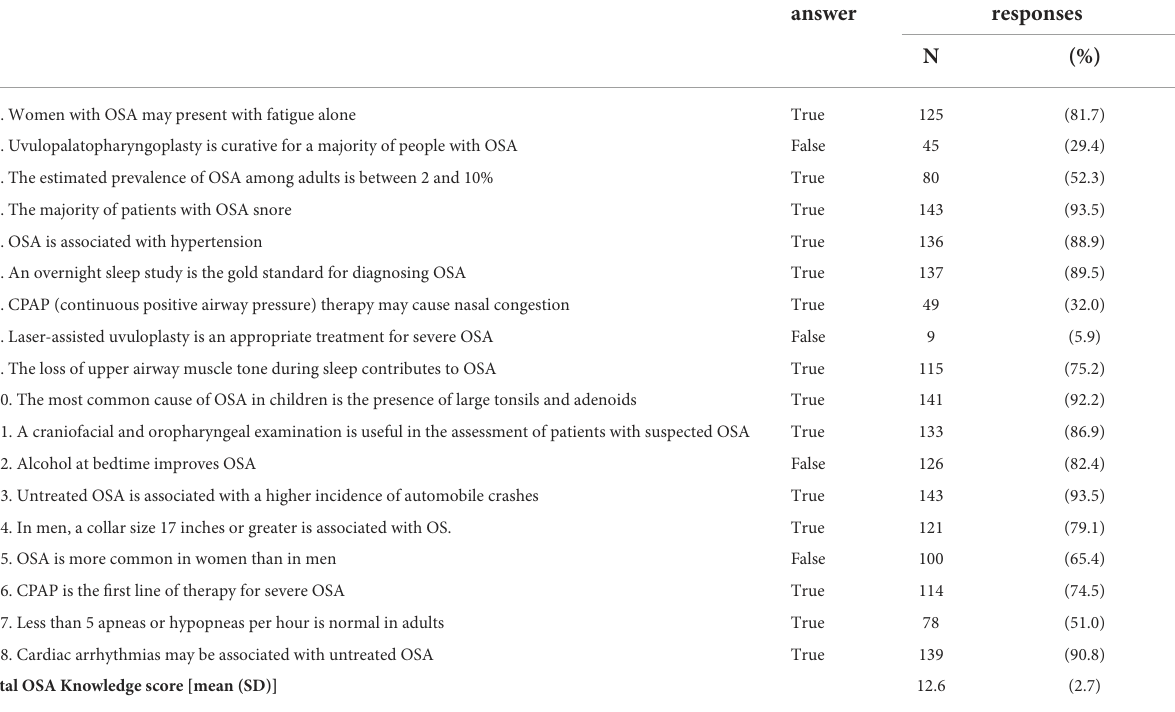
TABLE 2 Specific items of knowledge questions and the proportion of correct answers ( N =